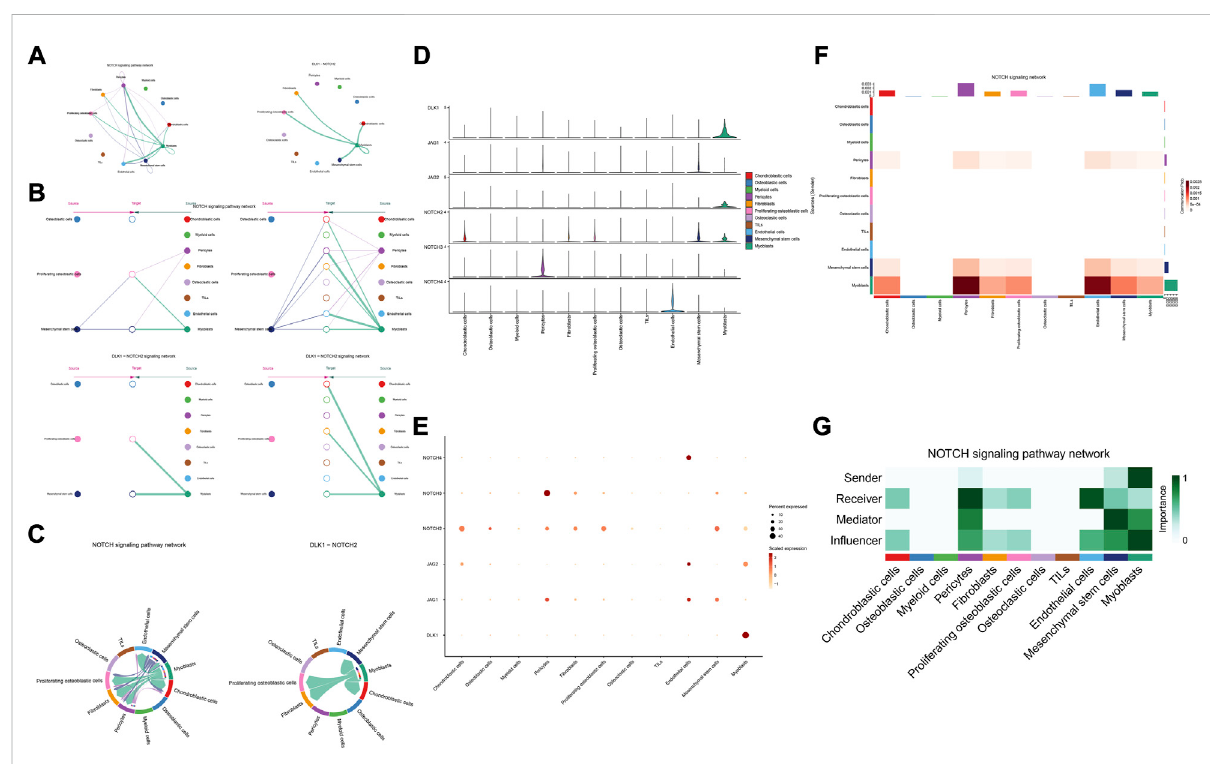
FIGURE 9 NOTCHsignalingpathway. (A – C) :ligand-receptorinteractionsofcells. (D,E) :theligand-receptorsexpressedbyeachmajorcelltype. (F,G) :the network of NOTCH signaling